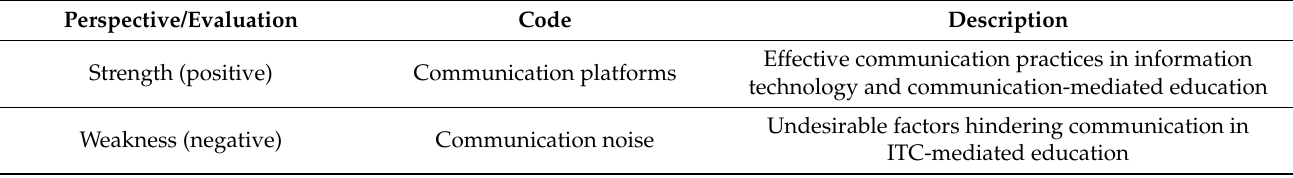
Table 4. Codes in the cultural-discursive agreement.